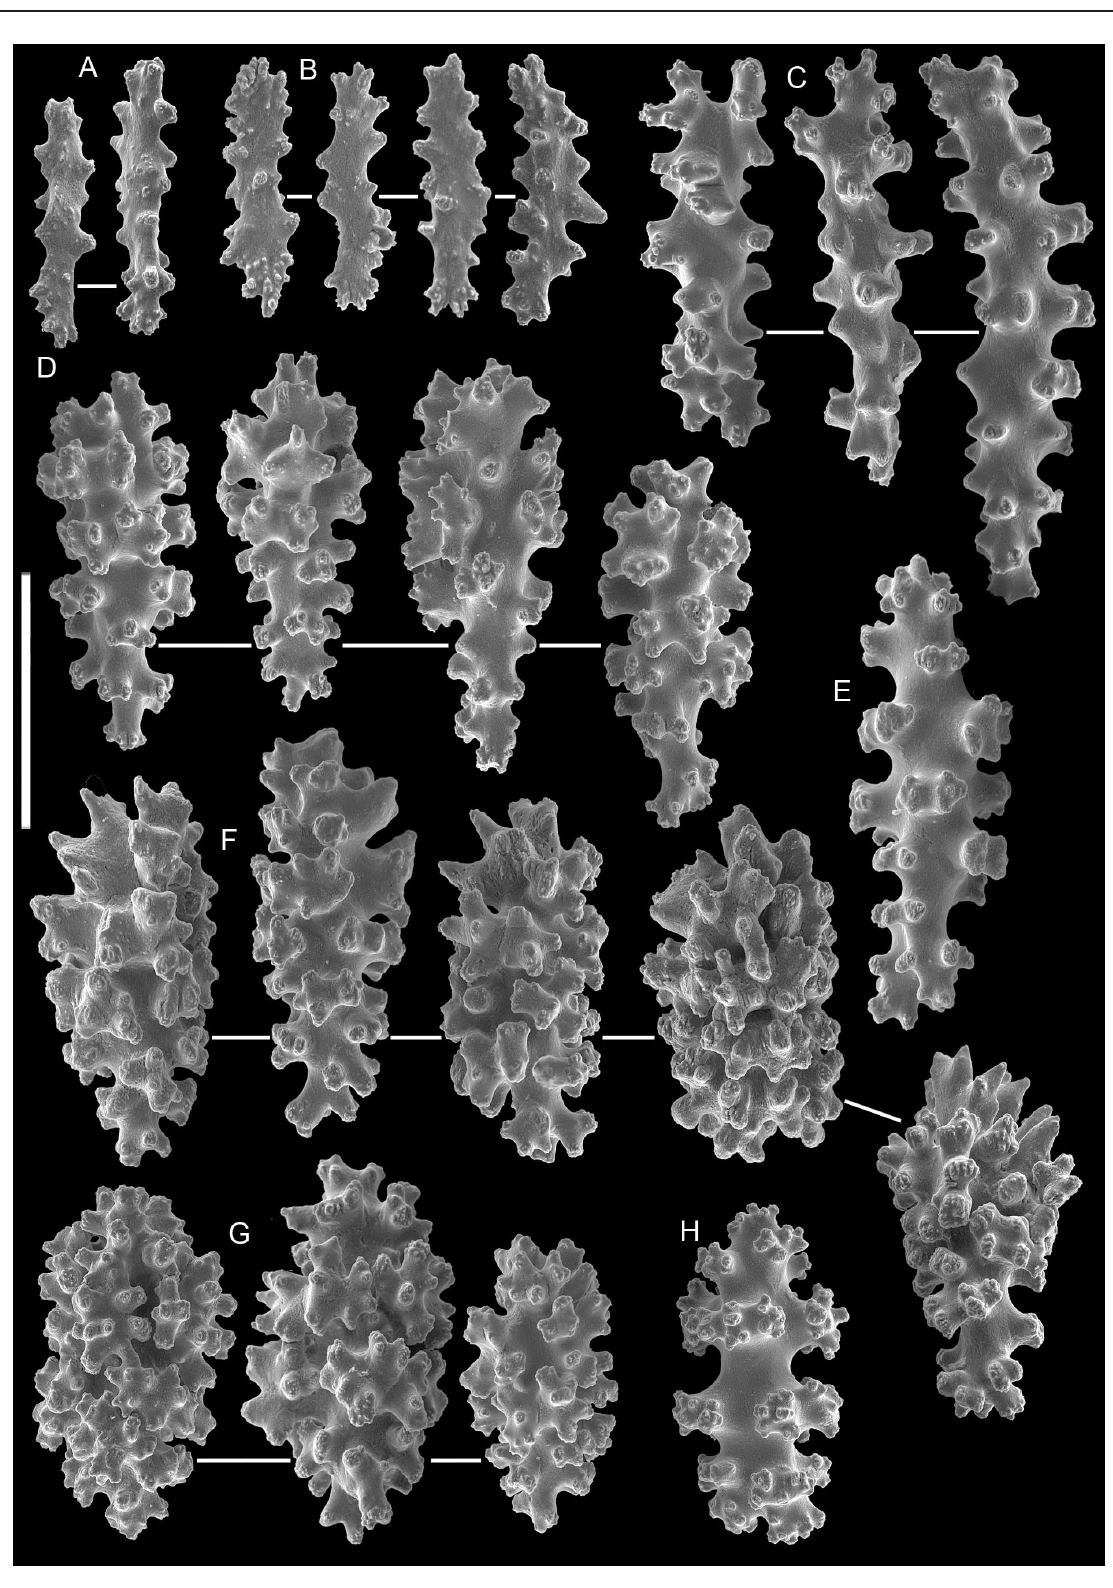
Fig. 5. Calcigorgia herba sp. nov., paratype MIMB 20745, sclerites from the tentacles of polyp. A . Modified clubs. B . Scales. C . Spindles. D . Warty clubs. E . Spindle. F . Poorly developed clubs with serrated processes. G . Ovals. H . Capstan (8-radiate). Scale bar = 0.1